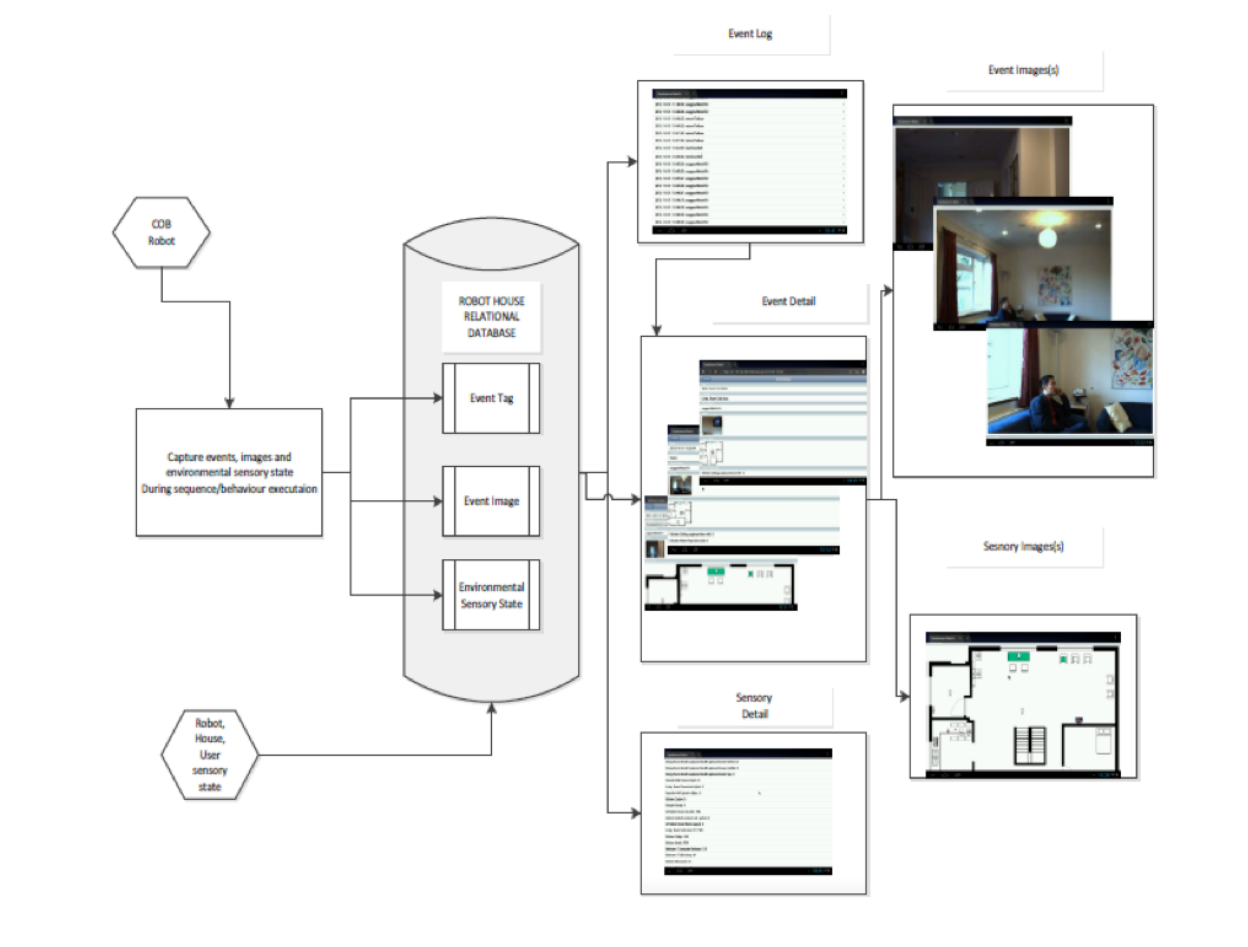
Figure 4. The memory visualisation and narrative system integrated into the overall memory